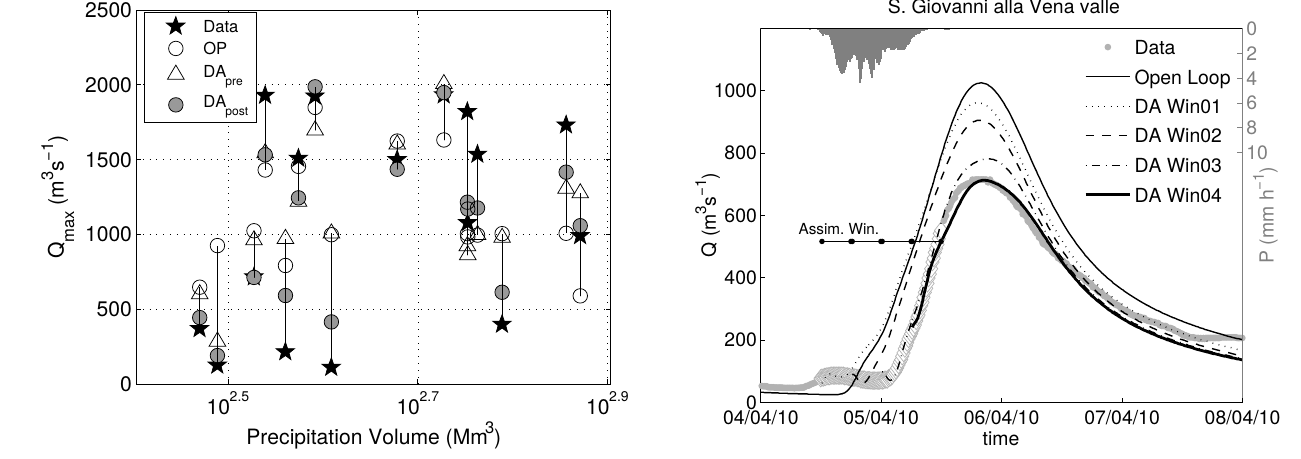
Figure 2. Flow peak versus precipitation volume at S. Giovanni alla Vena for the experiments of streamflow assimilation. Observations and open loop are black stars and white circles respectively. Values from data assimilation are white triangles/gray circles in case peaks at upstream locations are included/not included in the assimilation window.